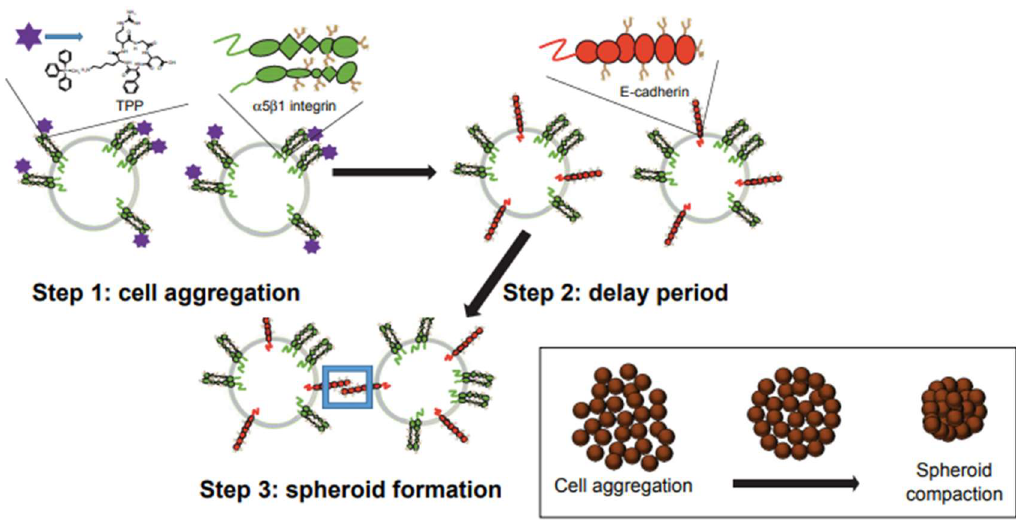
Figure 2. Formation steps of MCTS by the cyclo-RGDfK(TPP) peptide-based biochemical